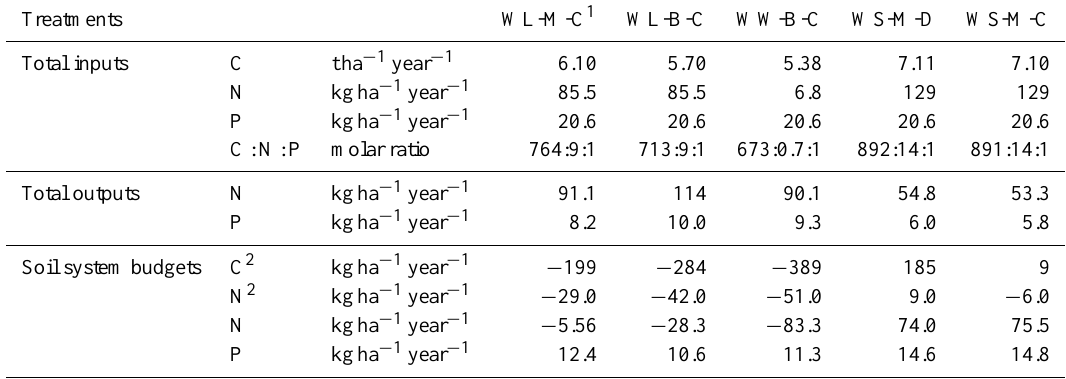
Table 4. Average C, N, and P in inputs and C:N:P molar ratios in inputs; N and P outputs; and C, N, and P soil system budgets for